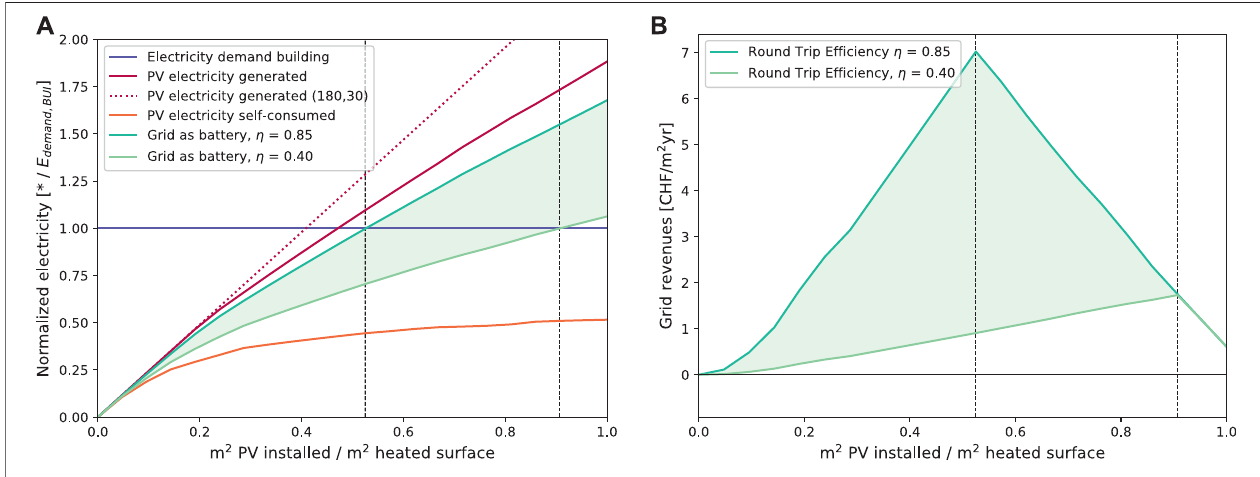
FIGURE 12 | (A) TheneedofPVpanelsofatypicalresidentialbuildinginSwitzerlandtoreachself-suf fi ciencywithre-import. (B) RevenuesasafunctionofinstalledPV capacity and grid ef fi ciency from the perspective of the grid. The grid buys electricity at a feed-in tariffs of 0.08 CHF/kWh and resells for electricity price 0.24 CHF/kWh.